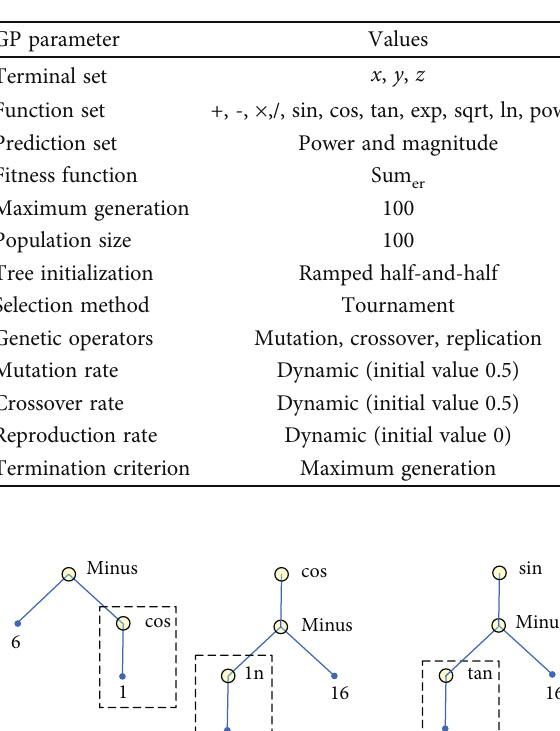
Table 2: Parameters of the GP model.